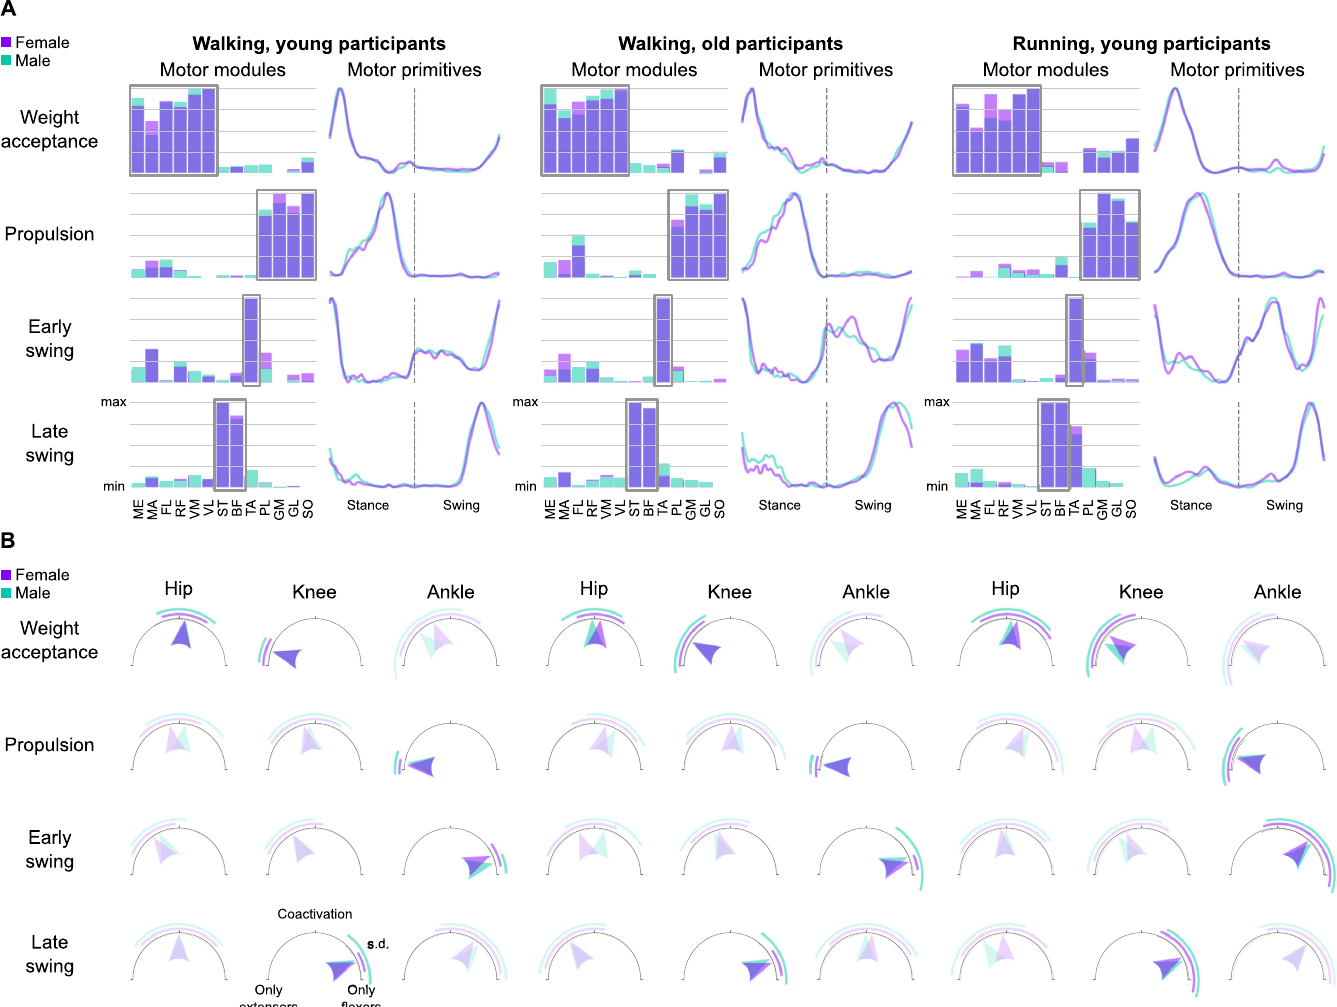
Fig 4. Overlayed muscle synergies and coactivation index. (A) The average muscle synergies of females and males are overlayed for comparison. The motor modules are presented on a normalized y-axis base: each muscle contribution within one synergy can range from 0 to 1 and each dot represents individual trials. Prime contributors to each synergy are highlighted by a rectangle. For the mean motor primitives (shaded standard deviation), the x-axis full scale represents the averaged gait cycle (with stance and swing normalized to the same amount of points and divided by a vertical line) and the y-axis the normalized amplitude. Muscle abbreviations: ME = gluteus medius, MA = gluteus maximus, FL = tensor fasciæ latæ, RF = rectus femoris, VM = vastus medialis, VL = vastus lateralis, ST = semitendinosus, BF = biceps femoris, TA = tibialis anterior, PL = peroneus longus, GM = gastrocnemius medialis, GL = gastrocnemius lateralis, SO = soleus. (B) Coactivation index calculated from the motor modules. Joints crossed by the most important muscles contributing to each muscle synergy are highlighted. Arrows pointing to the left show that muscle activity comes exclusively from extensors, while arrows pointing to the right mean that activity comes only from flexors. Arrows pointing upwards indicate perfect coactivation of flexors and extensors, meaning that the average module values for the flexors of that joint are the same as those for the extensors. The acronym “s. d.” stands for “standard deviation”.